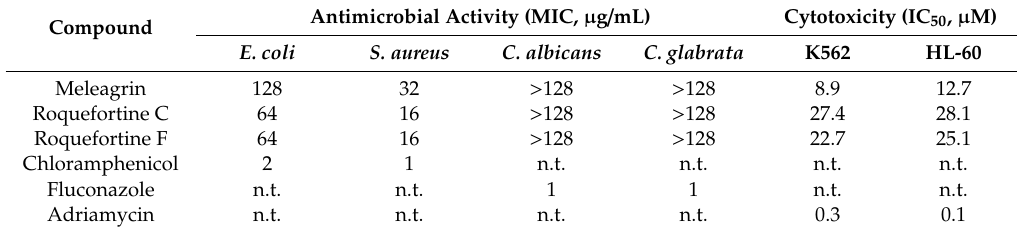
Table 1. Bioactivities of the meleagrin and roquefortine compounds from the ΔhdaA strain. Antimicrobial Activity (MIC, μg/mL) Cytotoxicity (IC 50 , μM) Compound E. coli